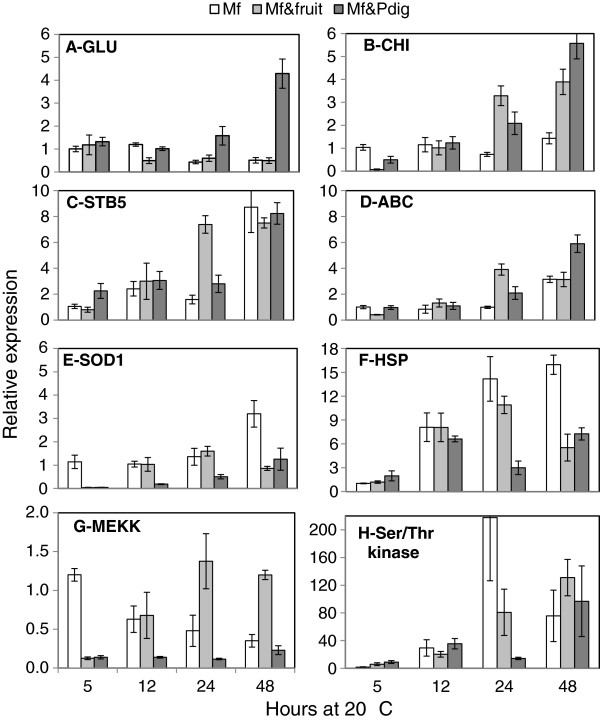
The differentially expressed genes profile detected by qRT-PCR. qRT-PCR was performed for of GLU (A), CHI (B), STB5 transcription factor (C), ABC transporter (D), SOD (E), HSP (F), MEKK (G) and Ser/Thr kinase (H) in M. fructicola cells (Mf), M. fructicola cells following interaction with P. digitatum, (Mf-Pdig) and M. fructicola cells following interaction with grapefruit (Mf-fruit) at 5, 12, 24 and 48 h after interaction. Values have been normalized to Mf at 5 h, arbitrarily set to 1. Vertical lines represent standard error for an average of three biological replicates.